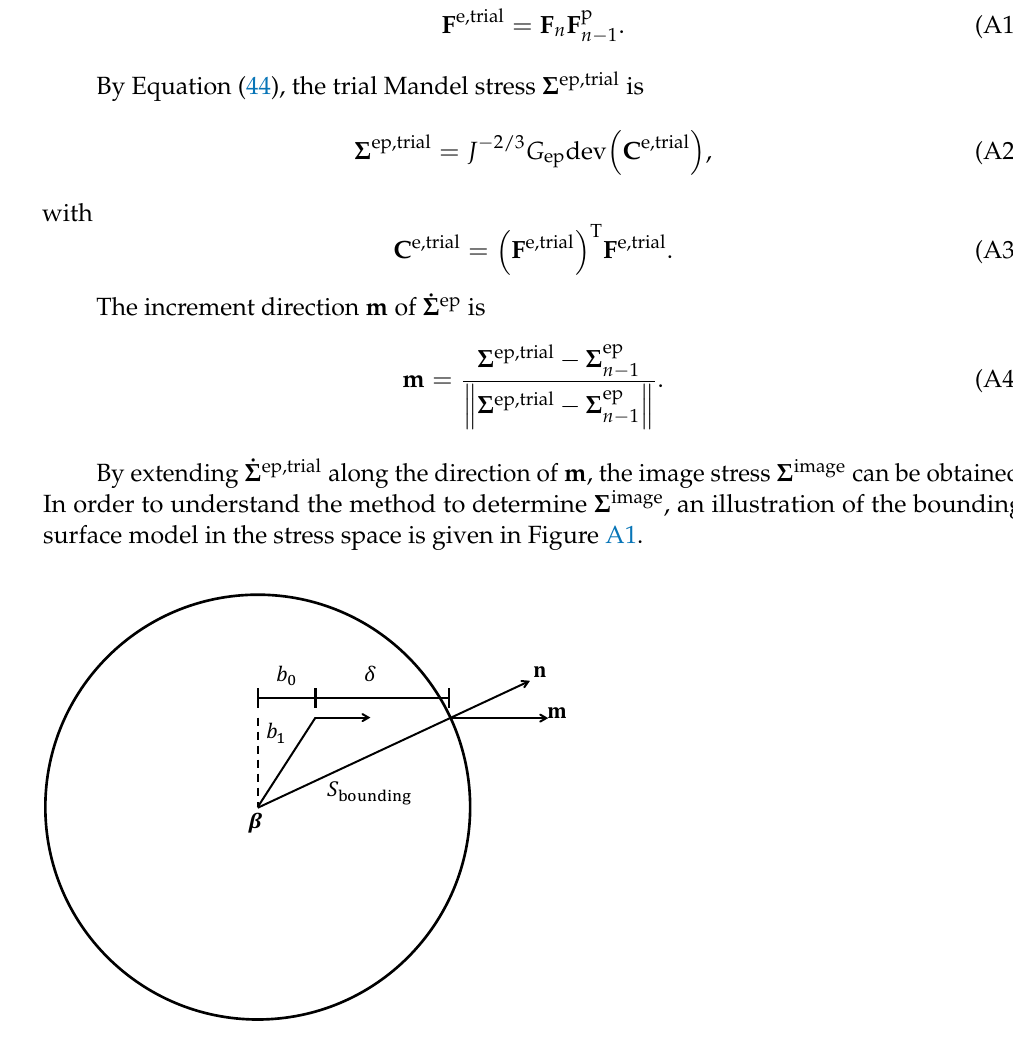
Figure A1. Illustration of the bounding surface in stress space. The distance from Σ ep,trial to β n − 1